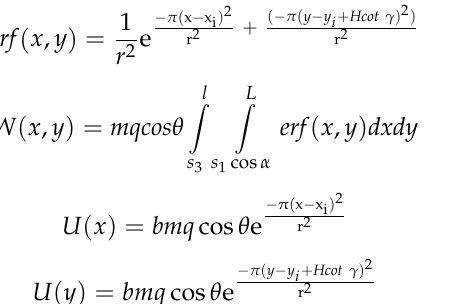
Fig 2 Figure 2. Probability distribution of particle subsidence according to the stochastic medium theoreti- cal